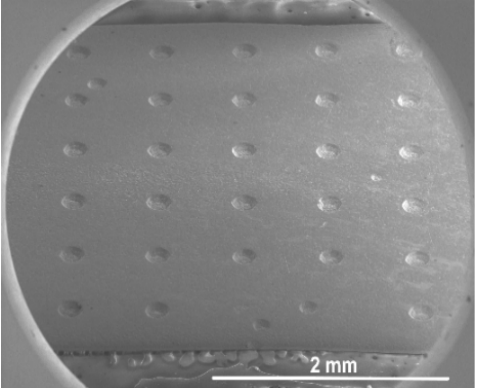
Figure 5. ( a ) Left-to-right: bright-field optical microscopy images showing the progressive pyrolysis of SU8 photoresist mask patterned with arrays of 200 μ m diameter circles after DS sputtering at low sputtering rate (V b = 600 V and I b = 30 mA) and a total working time of 1, 5, and 7 h. Apart from pyrolysis, no evident cracks or damage signs were visible. ( b ) Time evolution of the double layer depth (silicon + SU8) measured inside the photoresist-free areas, relative to “pre-sputtering” depth h 0 (i.e., starting photoresist mask thickness). Negative values of Δ h translate into a sputtering rate ratio of SU8-to-silicon bigger than unity, in contrast with simulation results. A nonlinear behavior was observed.